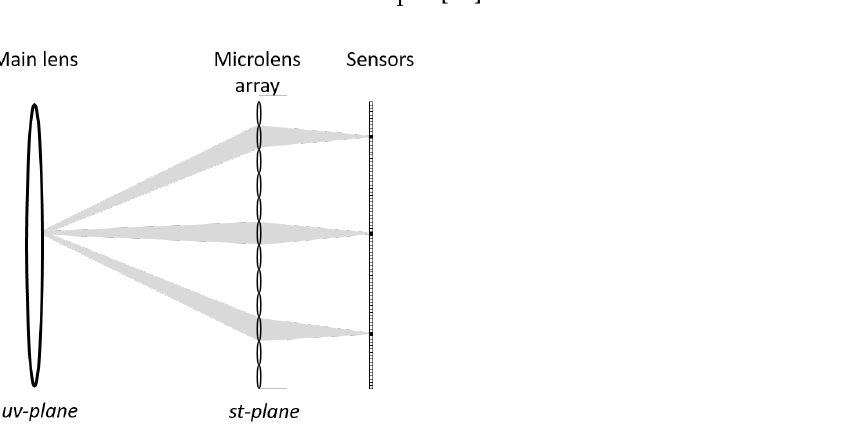
Figure 2. Diagrammatic representation of a lenslet-based plenoptic camera to capture light field images